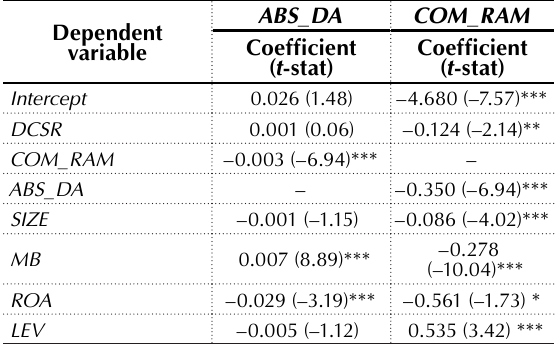
Table 5. Heckman second stage